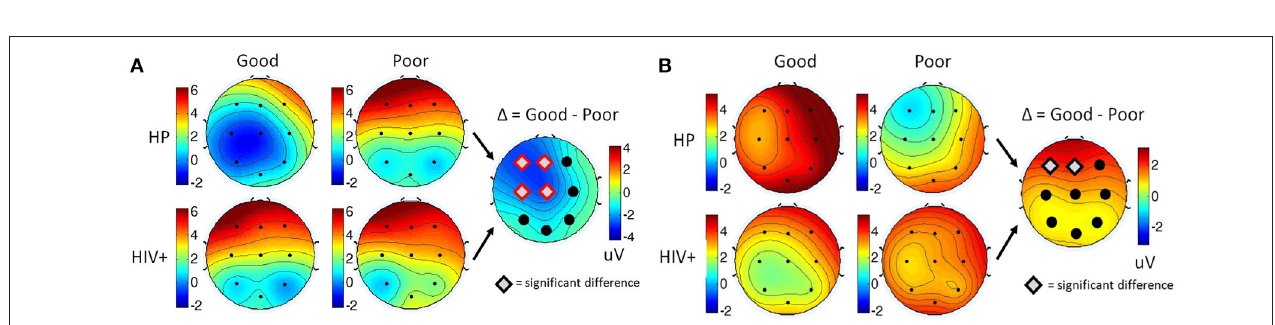
FIGURE 9 | Topographical maps of (A) the average P200 component in Non-Target ERP trials (left panel) and (B) average LPP component in Target trials (right panel) plotted for all subgroups: Good/HP, Good/HIV + , Poor/HP and Poor/HIV + . In each panel the difference plot between total Good and Poor groups is shown on the right side. Channels with significant differences between the two groups ( t -test, p < 0.05) are marked with a diamond shape.